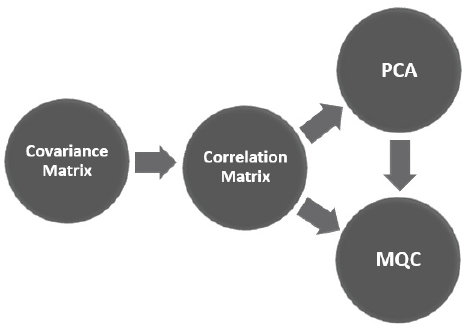
Figure 2. Relationship of statistical methods for simultaneous screening.